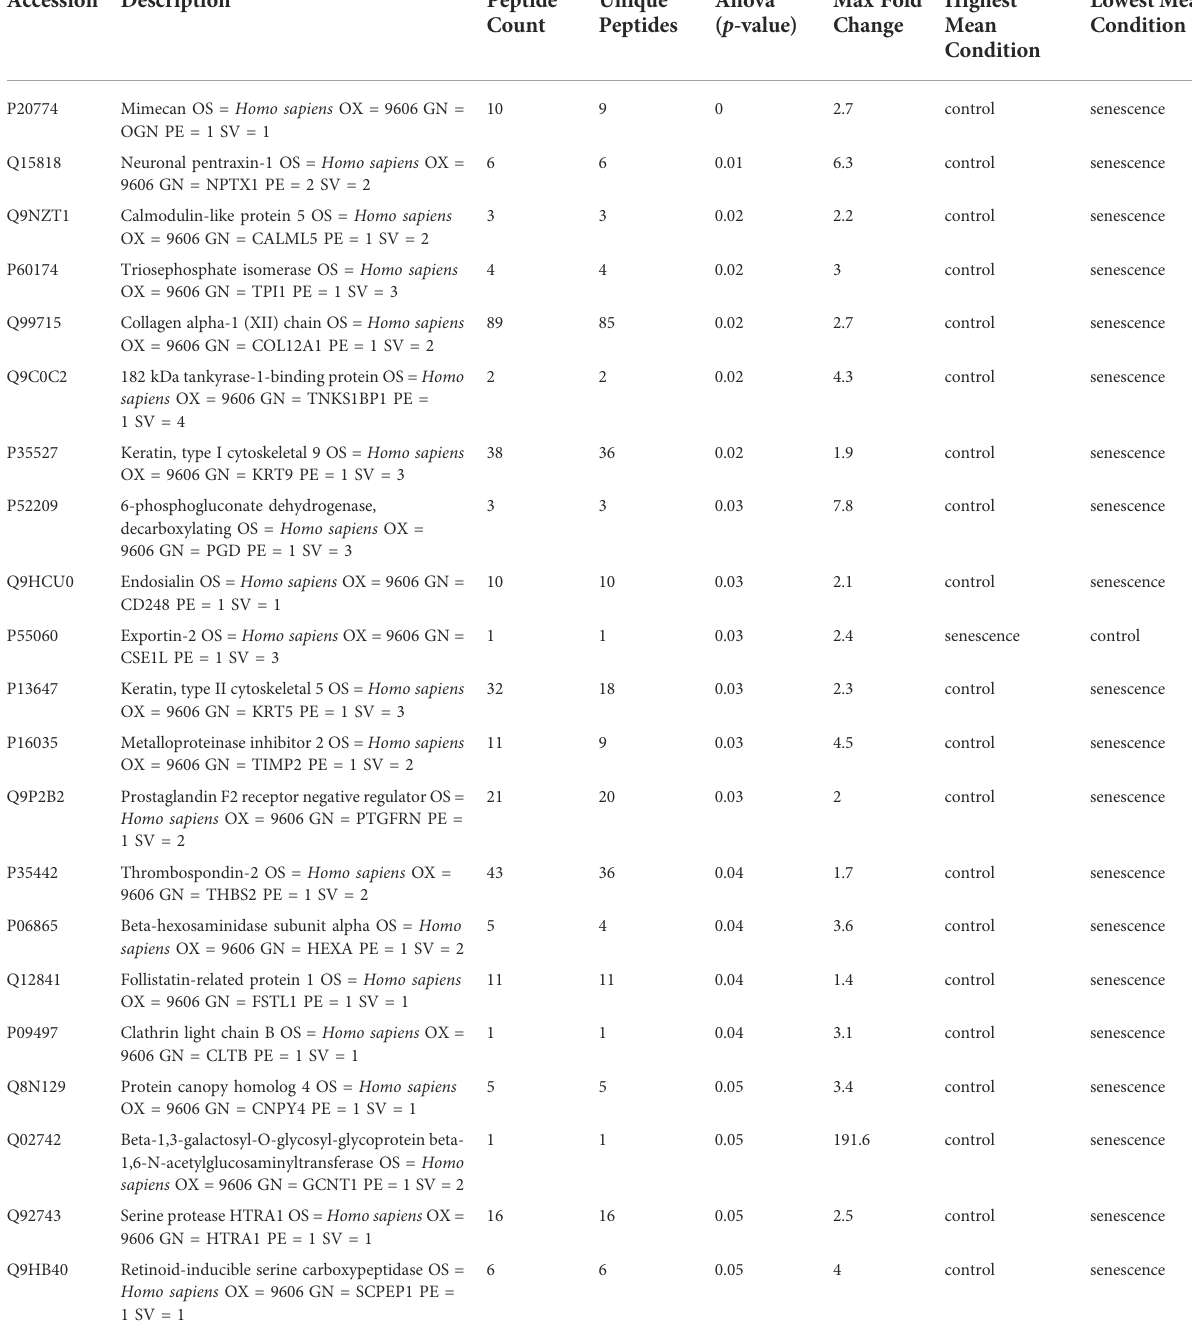
TABLE3 LC-MS/MS analysis ofdifferentiallyabundantproteinsinsenescent fi broblastderived EVs andnon-senescent fi broblastderived controlEVs. Accession